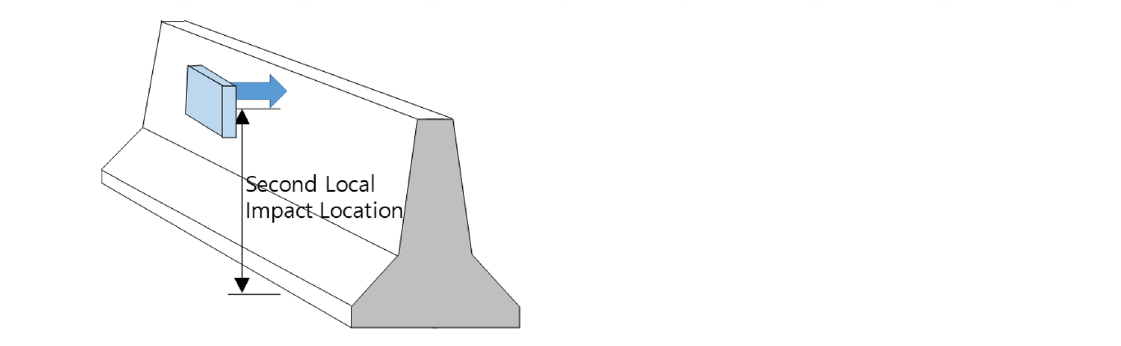
Figure 3. Conceptual drawing of the local impact SPH